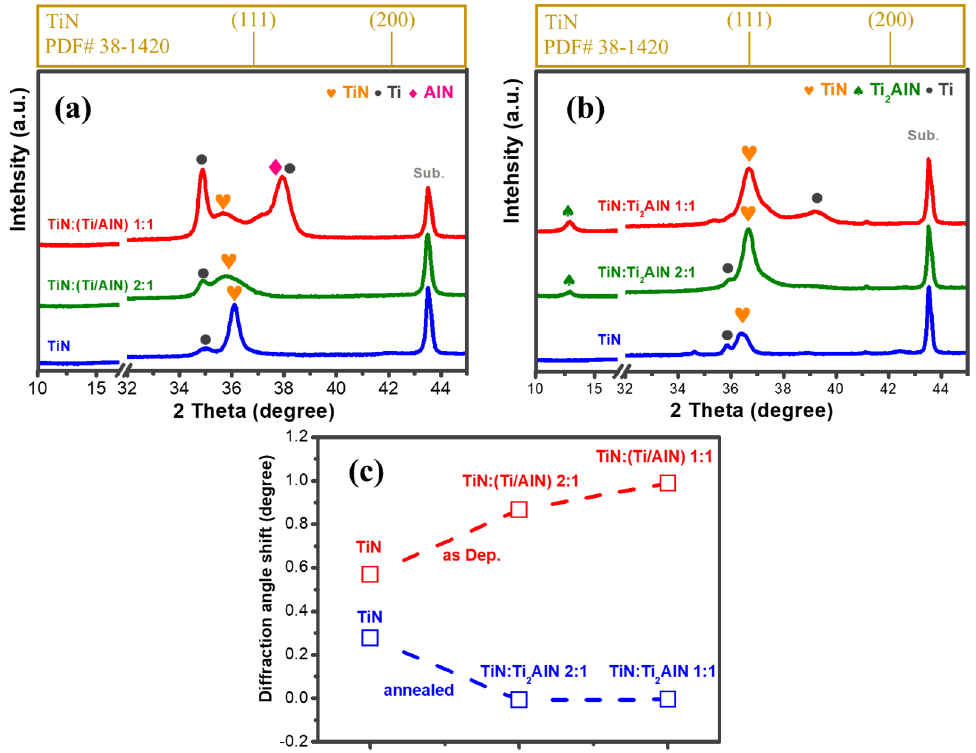
Figure 2. θ–2θ XRD spectra of the as-deposited ( a ) and annealed ( b ) TiN and TiN/(Ti/AlN) multilayers on SS substrate, and the TiN (111) plane shift ( c ).